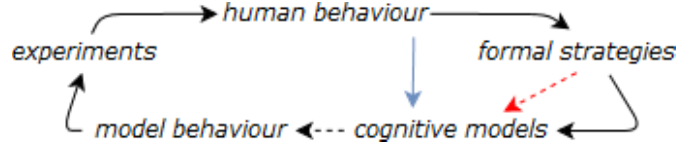
Figure 1. A diagram showing the elements involved in our research. Dashed arrows indicate automated processes. The red dashed arrow indicates our place in cognitive modeling research, as we aim to automate the creation of cognitive models from formal strategies. The blue line indicates the classical method of constructing cognitive models based on human